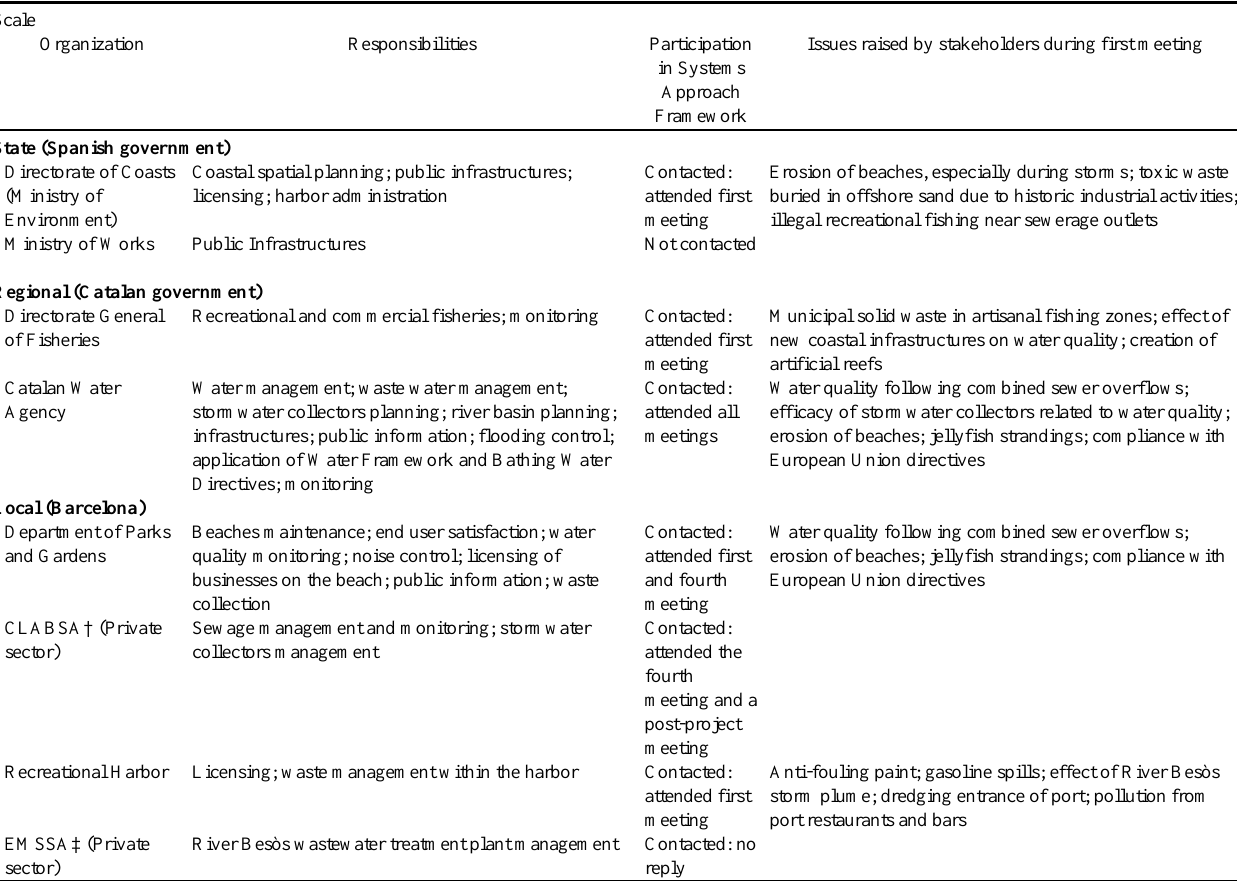
Table 1 . List of stakeholders and meetings